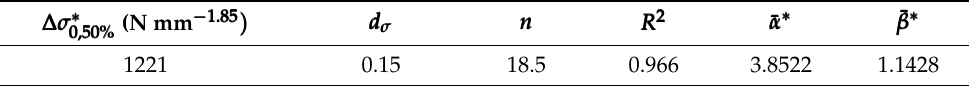
Table 8. Best-fitting of free-parameters entering Equations (8) and